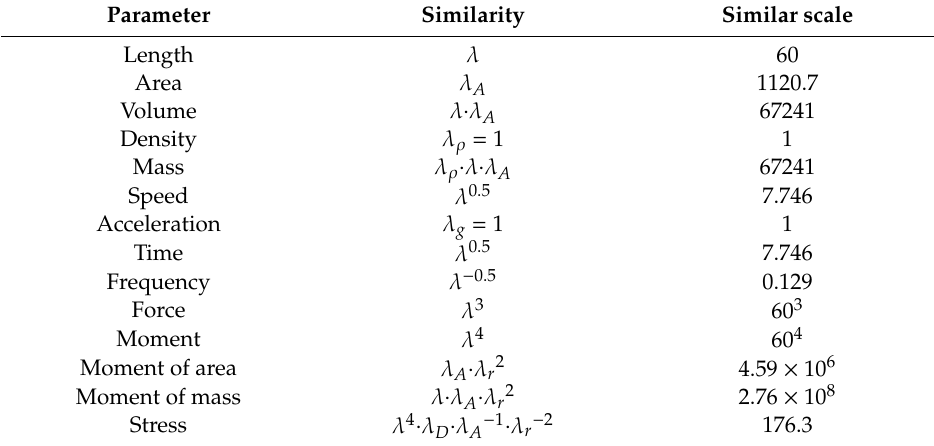
Table 1. The similarity relation of basic parameters for the model design. Taking the platform leg as an example.